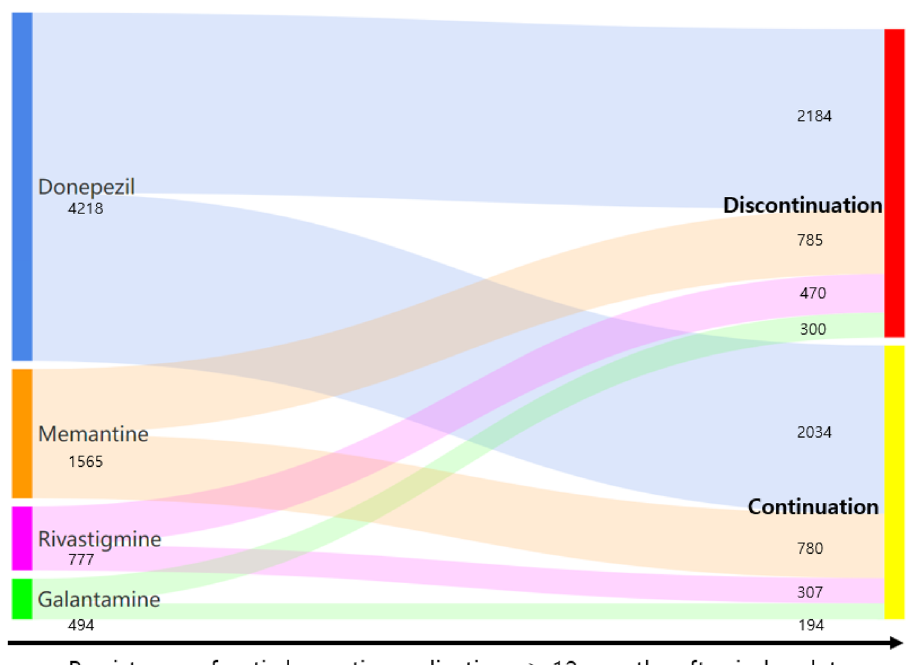
Figure 6. The drug continuation of each anti-dementia medication over 12